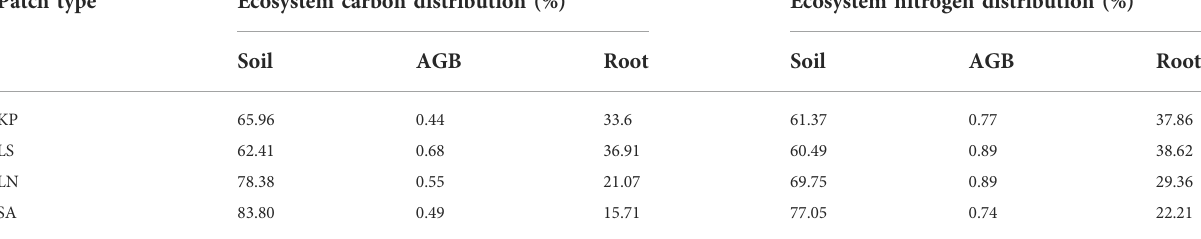
TABLE 1 Distribution of ecosystem carbon and nitrogen among soil and vegetation. Patch